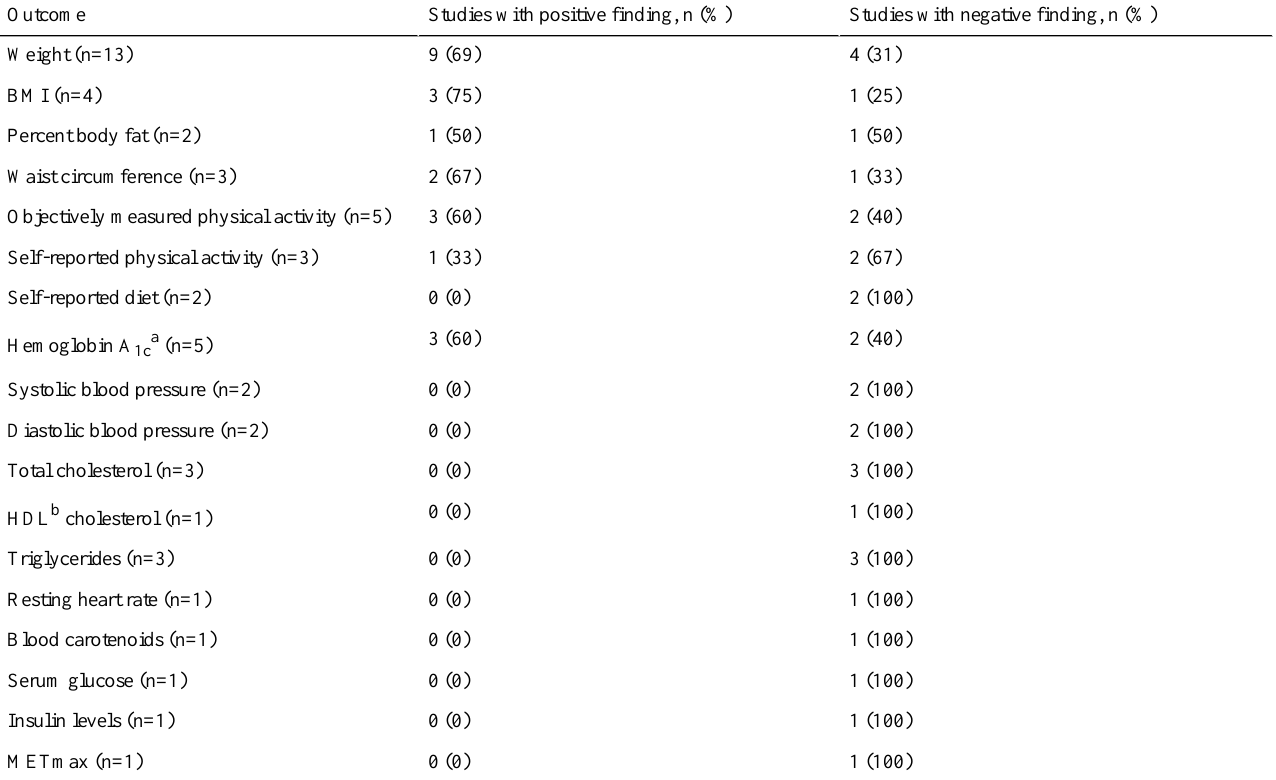
Table 1. Findings for the relationship between user engagement and the cardiovascular disease health behavior change or health outcome.